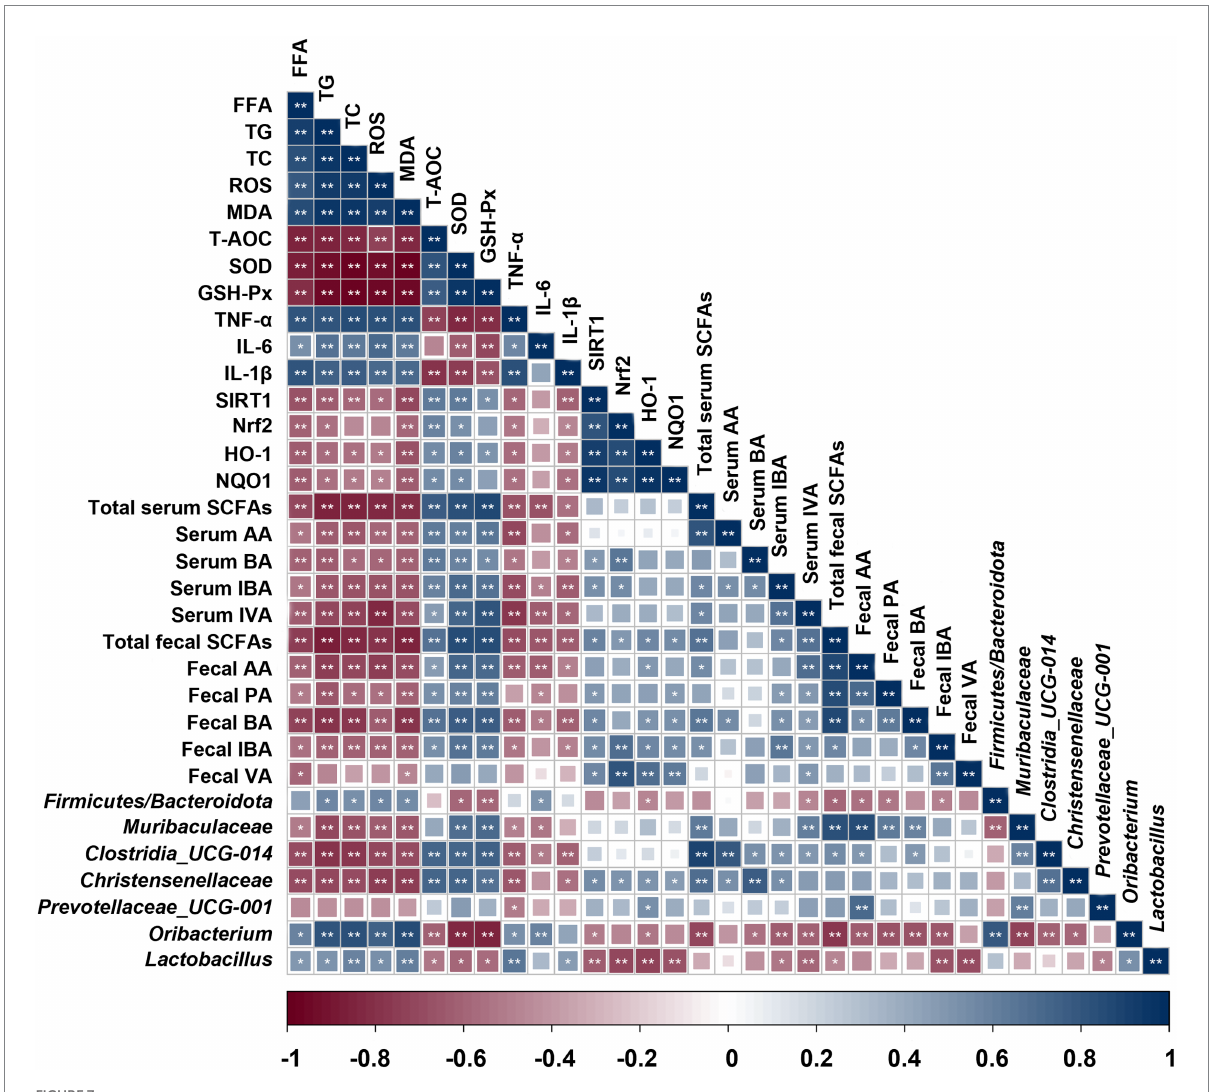
FIGURE 7 Correlation between indicators of liver injury, oxidative stress-related enzymes, SCFAs levels and gut microbiota composition changes. Blue indicates positive correlation and red indicates negative correlation. ** p < 0.01, * p <